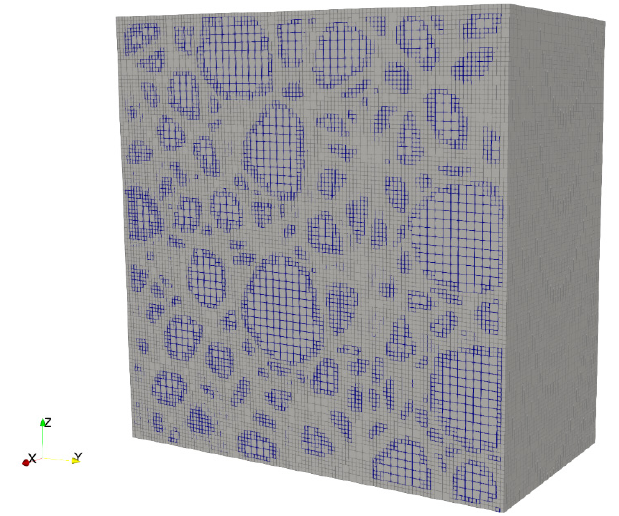
Figure 6. Balanced octree meshing of a typical fully graded concrete sample.